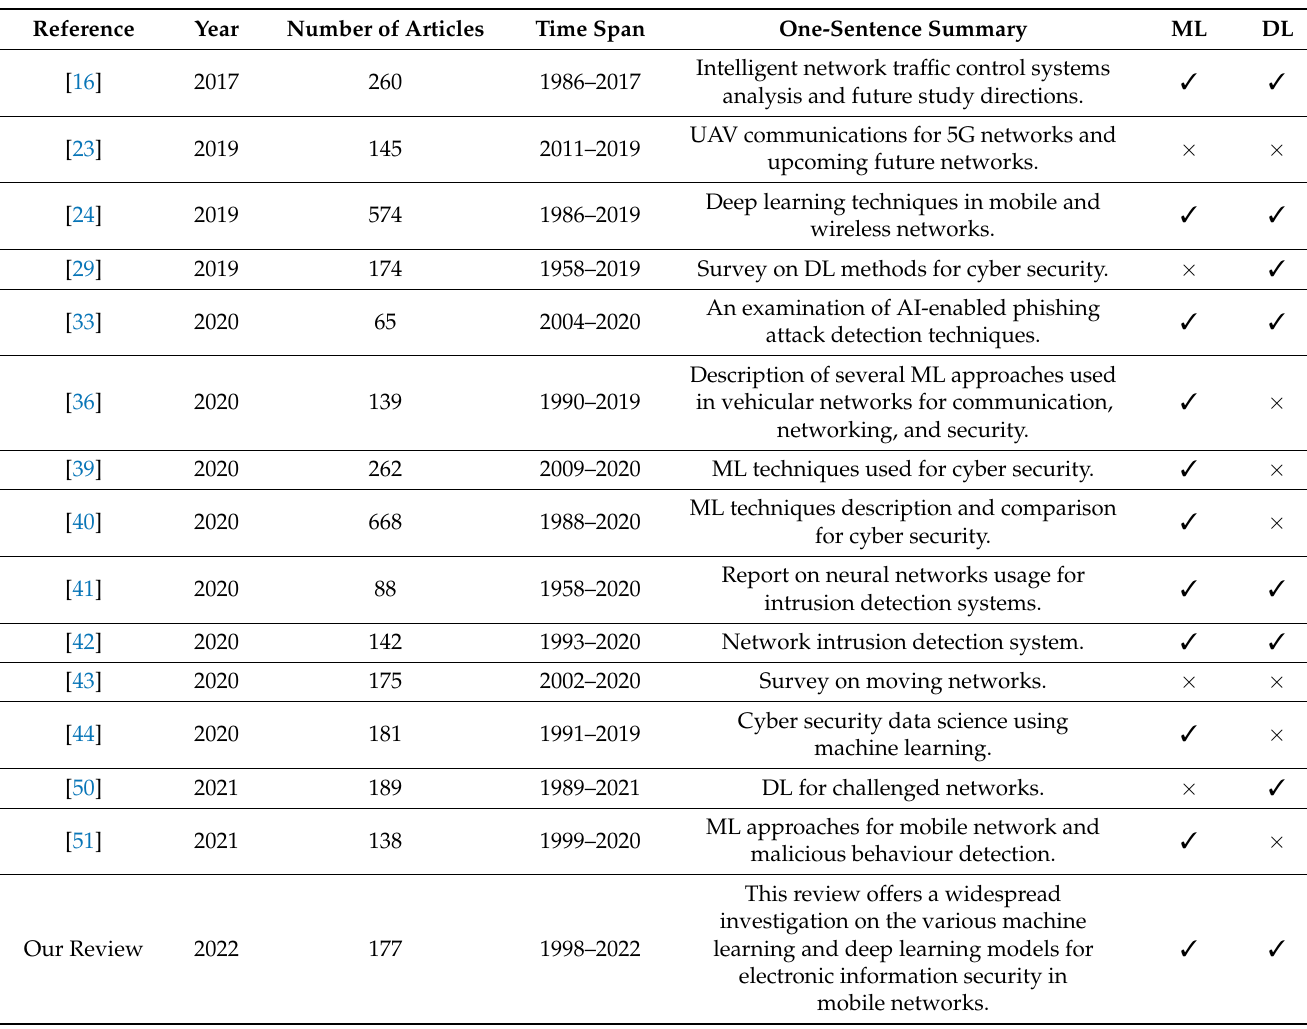
Table 1. Comparison with Previous Reviews. ( (cid:51) : Discussed, × : Not